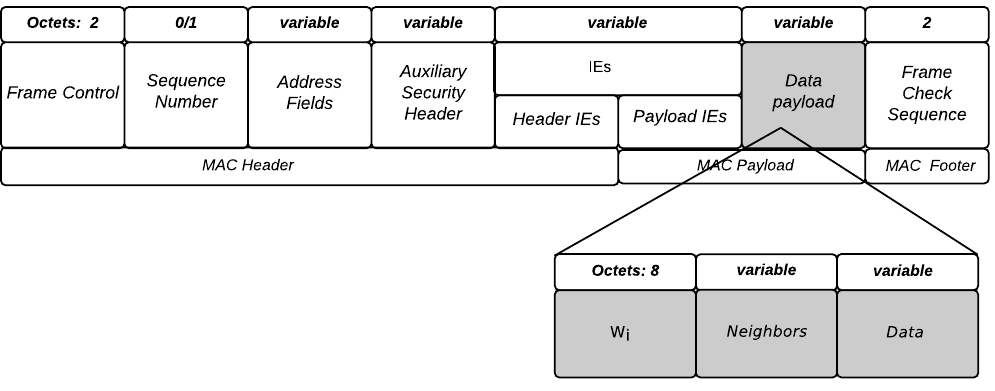
Figure 4. Data frame format.